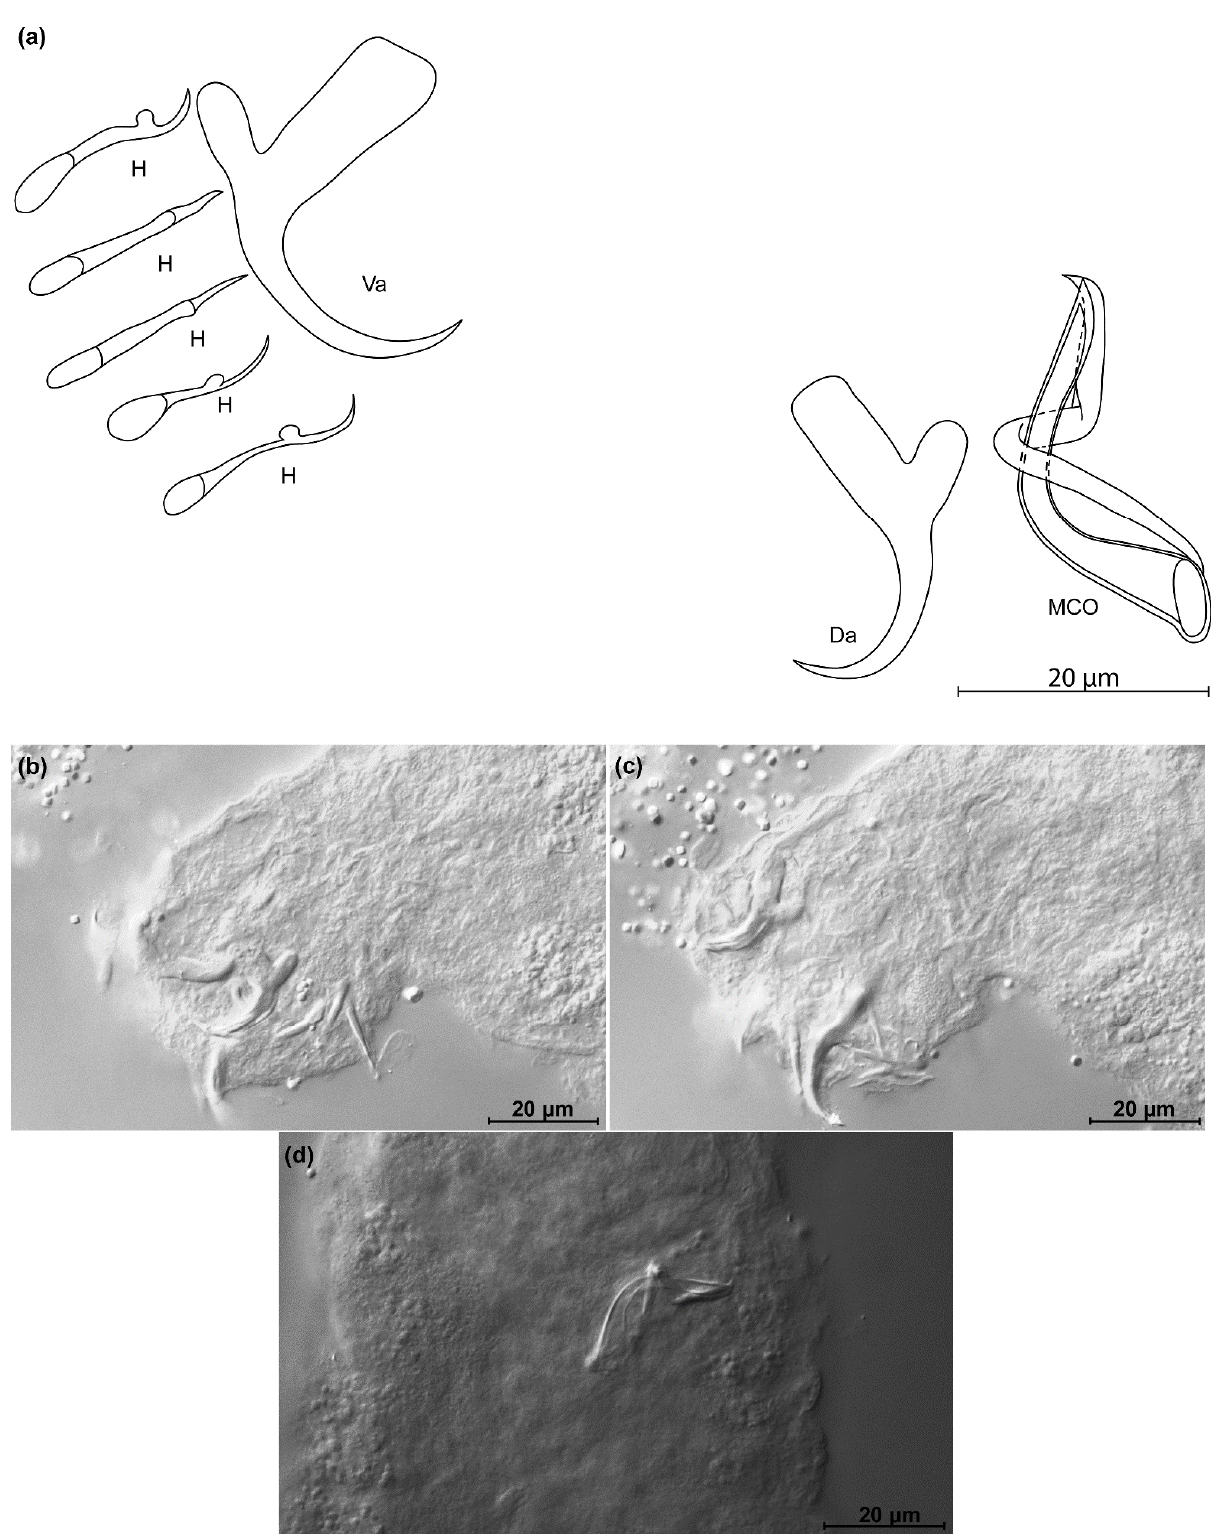
Figure 14. Kapentagyrus chochamandai n. sp. (ex Potamothrissa acutirostris ). ( a ) Drawings of sclerotized structures, Va-ventral anchors, Db-dorsal bar, Vb-ventral bar, H-hooks (hook pairs not identified). ( b ) Micrograph of ventral anchor and ventral bar. ( c ) Micrograph of dorsal anchor. ( d ) Micrograph of MCO.